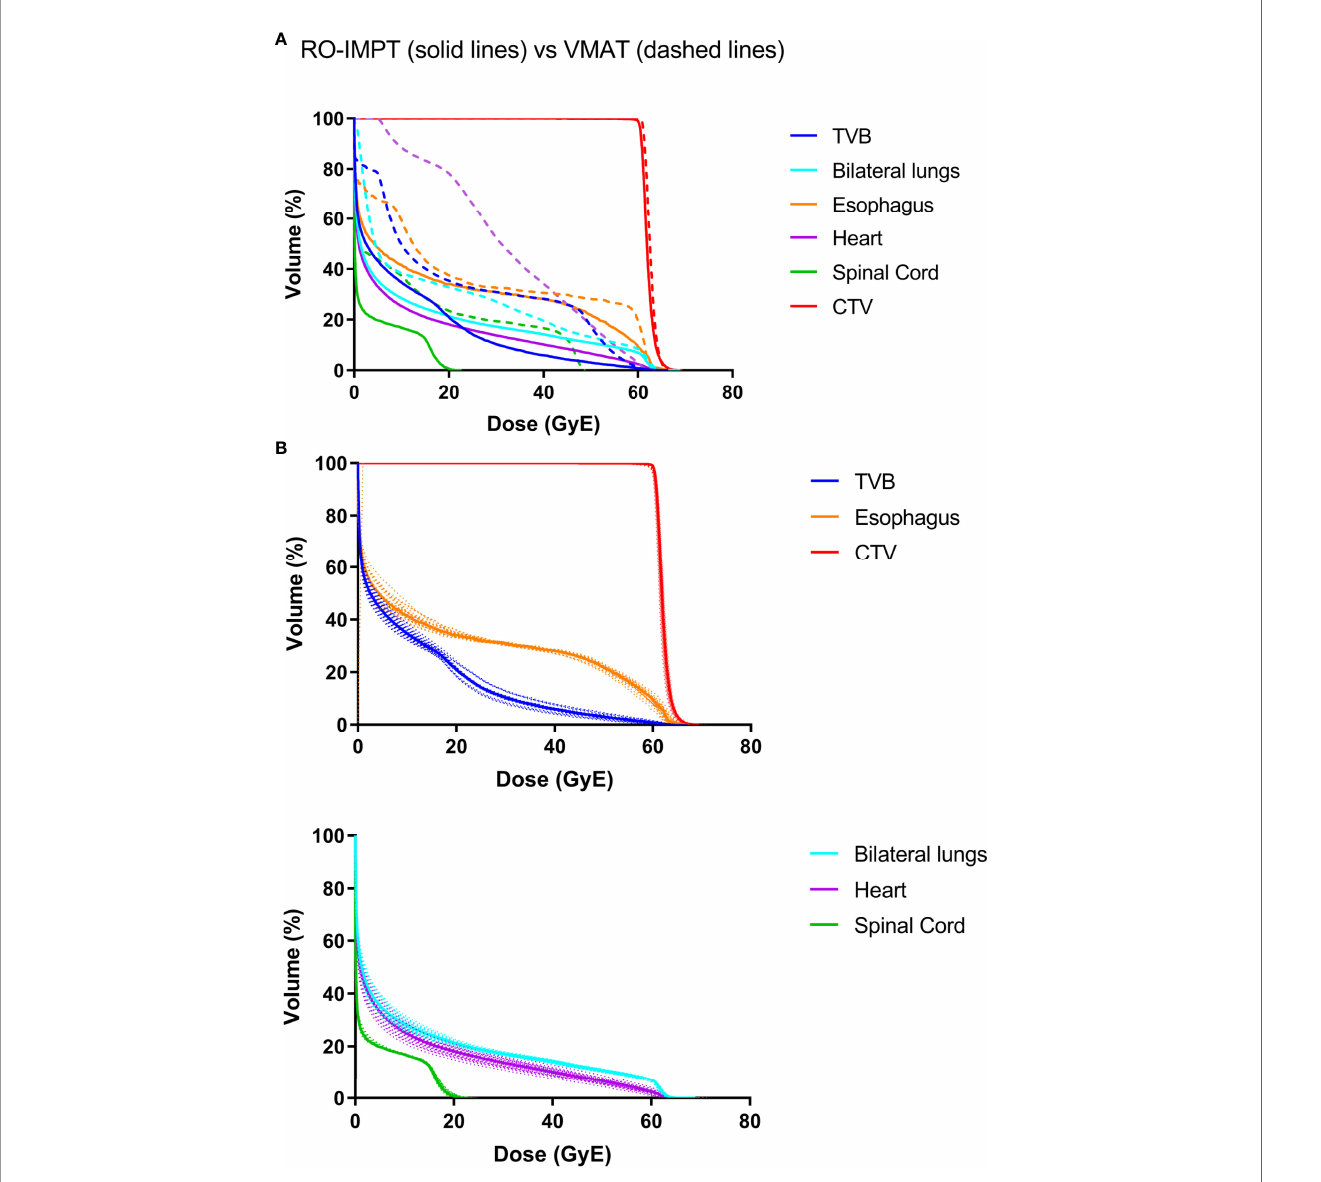
FIGURE 1 | (A) A representative dose volume histogram (DVH) of patient #20. The solid line is RO-IMPT, and the dashed line is VMAT. (B) DVHs perturbation of the 21 worst scenarios of RO-IMPT. TVB, thoracic vertebral